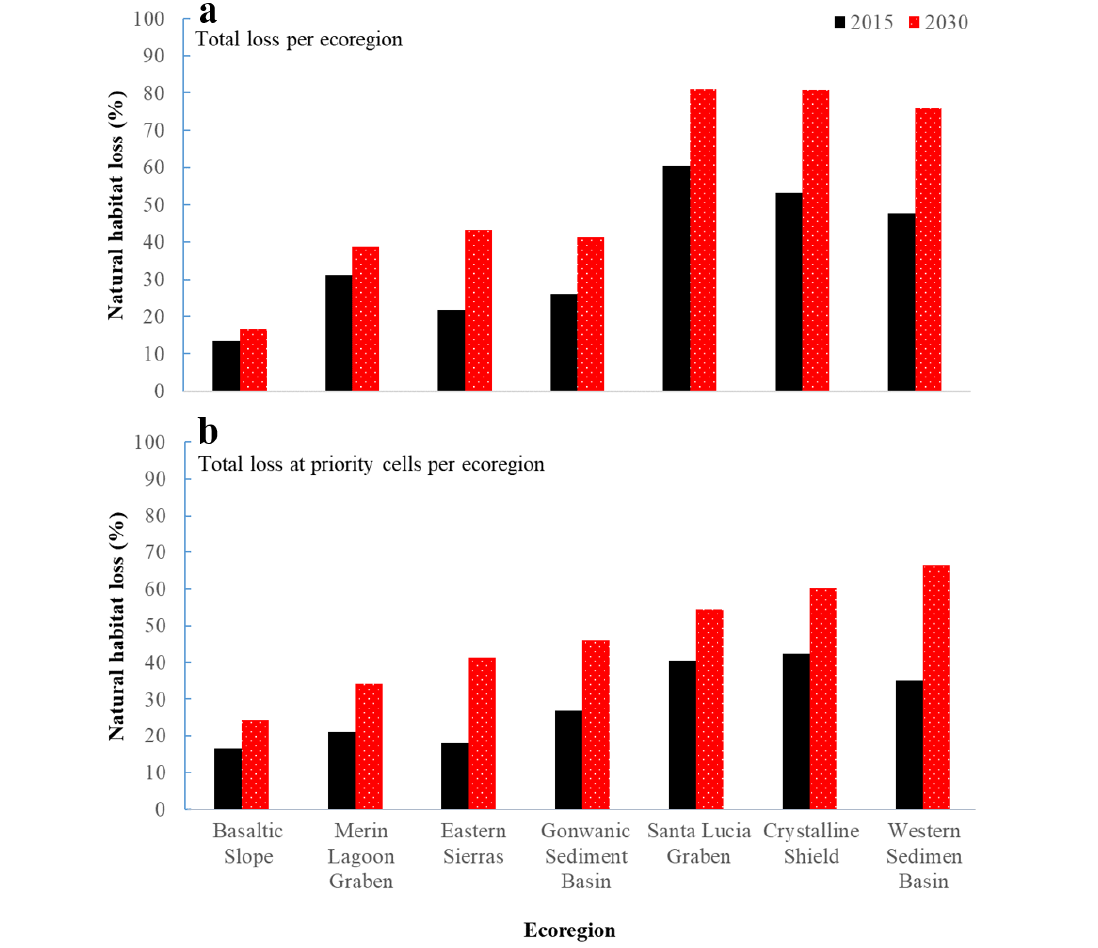
Fig. 5 . (a) Observed natural habitat loss per ecoregion in 2015 and projected loss according to the 2030 scenario. (b) Observed natural habitat loss at the priority cells (i.e., highest vulnerable cells, top 17%) for diversity conservation of vertebrates and woody plants in 2015, and projected loss according to the 2030